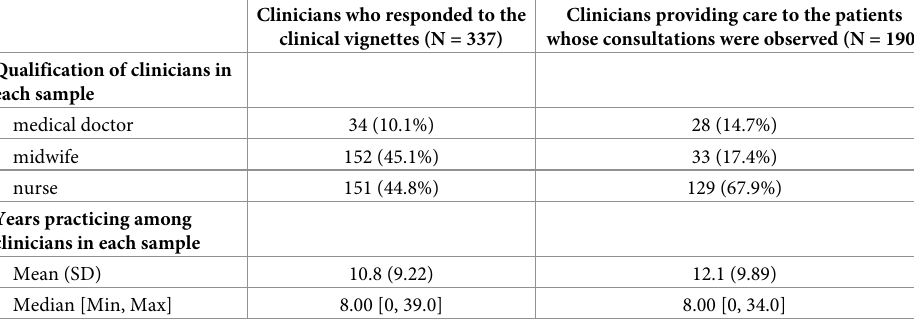
Table 1. Descriptive characteristics of the sampled